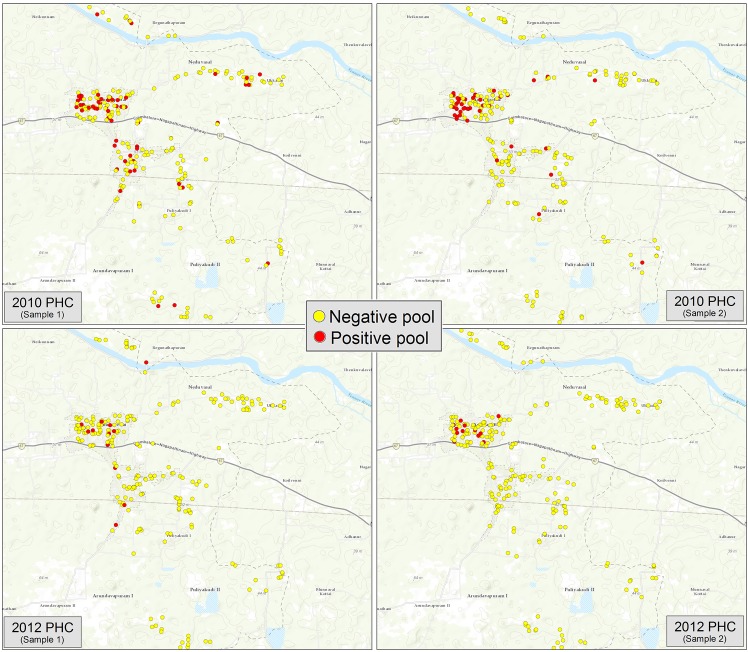
Map of positive and negative pools by household location in the PHC evaluation unit, 2010 and 2012.